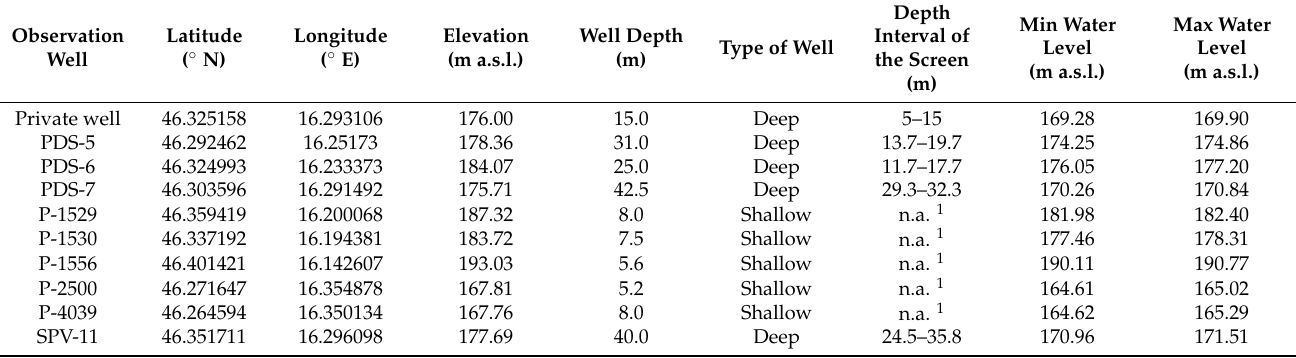
Table 1. Observation Wells